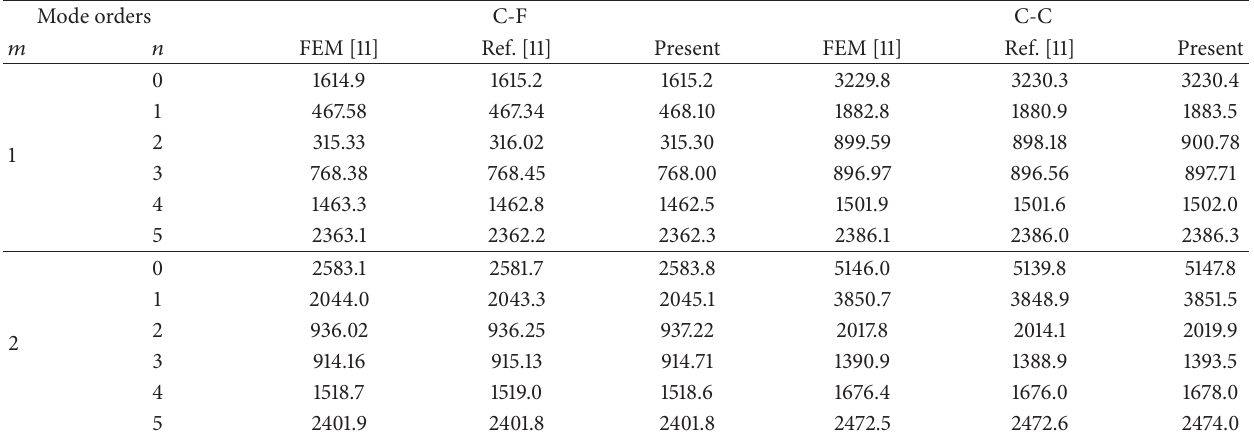
Table 15: Comparison of the natural frequencies for a circular cylindrical shell with C-F and C-C boundary conditions. Mode